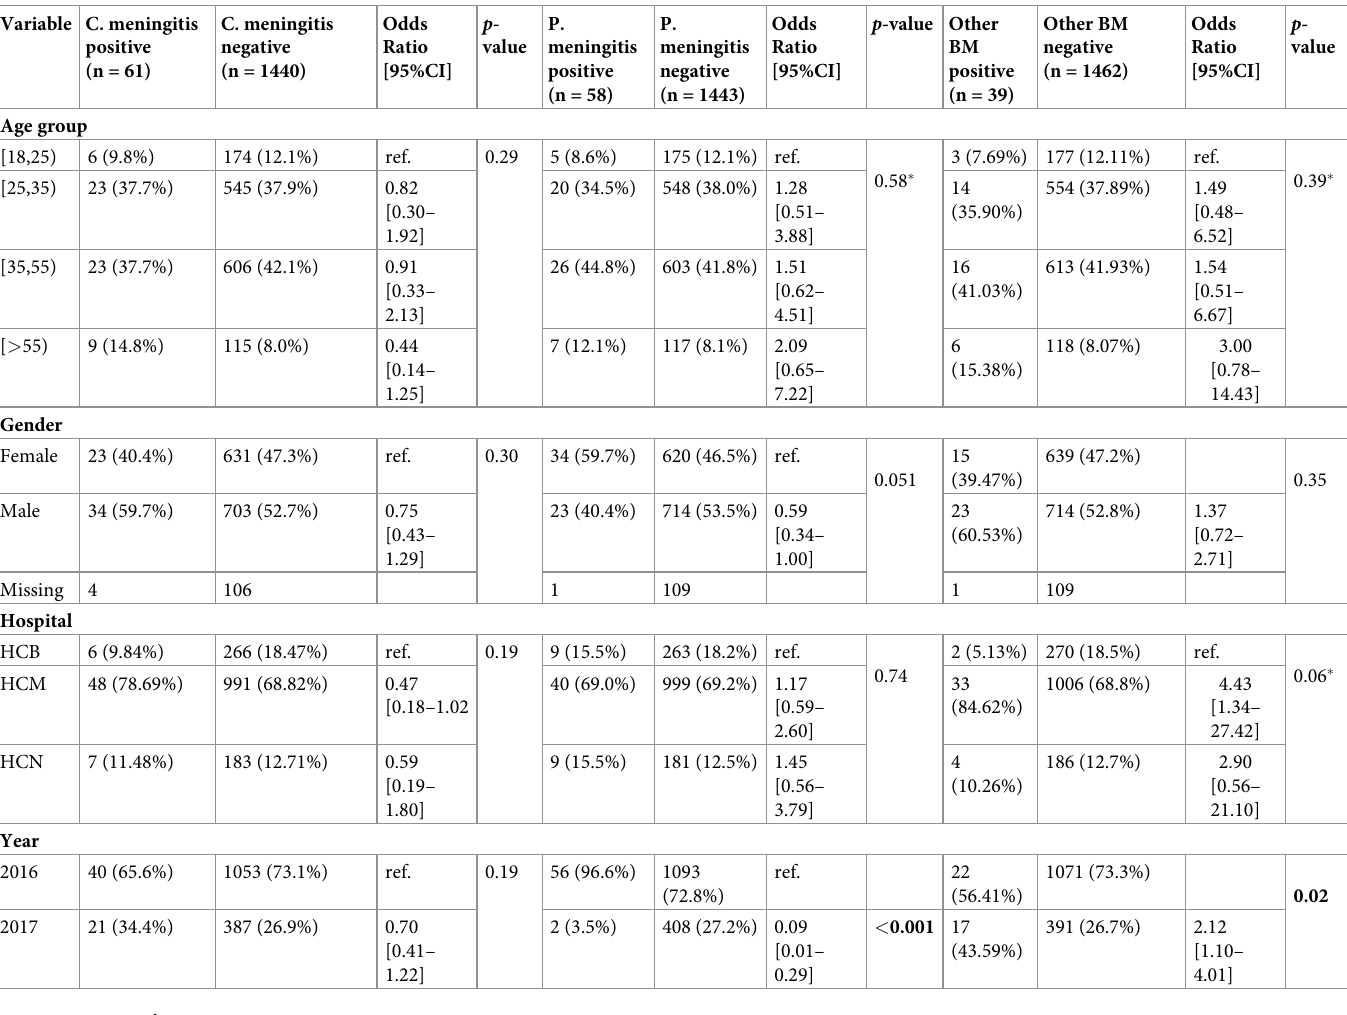
Note: BM : Bacterial meningitis � Fisher’s Exact